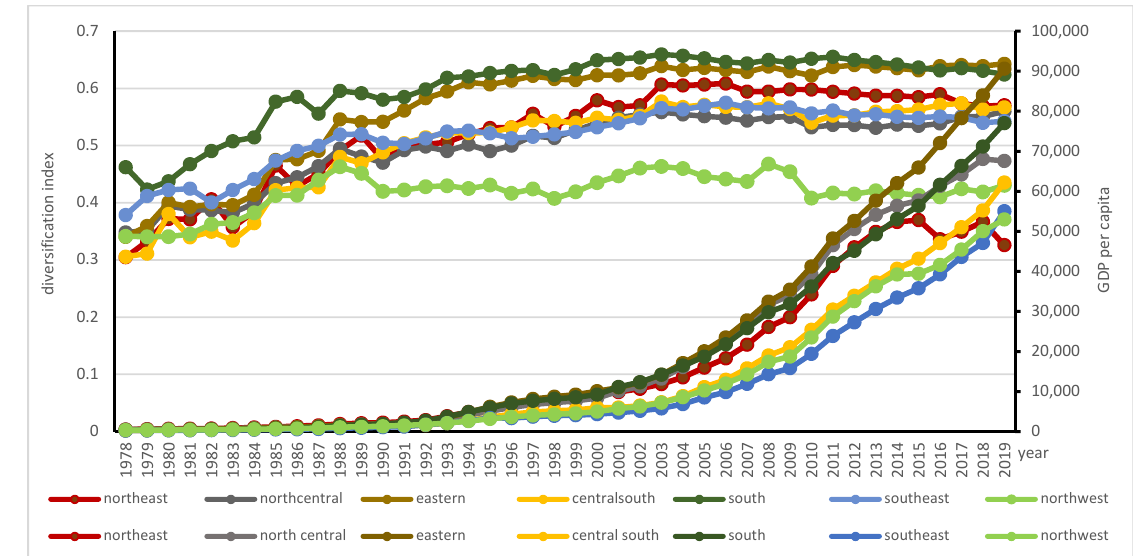
Figure 11. Geographic distribution of AD across regions in China. The two selected regions with the highest and lowest AD, the eastern and northwest regions, are used to further examine the stages of AD across China. The eastern region was highly diversified over time; its AD levels ranged from 0.34 in 1978 to 0.64 in 2019, the highest turning point of 0.64 with per capita GDP of RMB 90643 /person in 2019 (see Figure 11). With the highest per capita GDP, the contribution of the crop subsector in Shanghai decreased from 82.93% in 1978 to 50.81% in 2019, while animal husbandry in- creased from 11.93% in 1978 to 24.94% in 2019. Jiangsu had a modest diversification level and its per capita GDP ranked second in this region. The contribution of the crop subsector in Fujian decreased from 77.68% in 1978 to 38.28% in 2019, while animal husbandry in- creased from 10.51% in 1978 to 19.75% in 1994, and to 19.72% in 2019. By contrast, for Shandong province, the contribution of crop subsector decreased from 82.93% in 1978 to 50.81% in 2019, while animal husbandry increased from 11.93% in 1978 to 32.7% in 1994, and to 24.94% in 2019 (see Figure 12). The development of animal husbandry plays an important role in shifting agricultural diversification into the third stage of mixed farming and cropping systems in the eastern region.